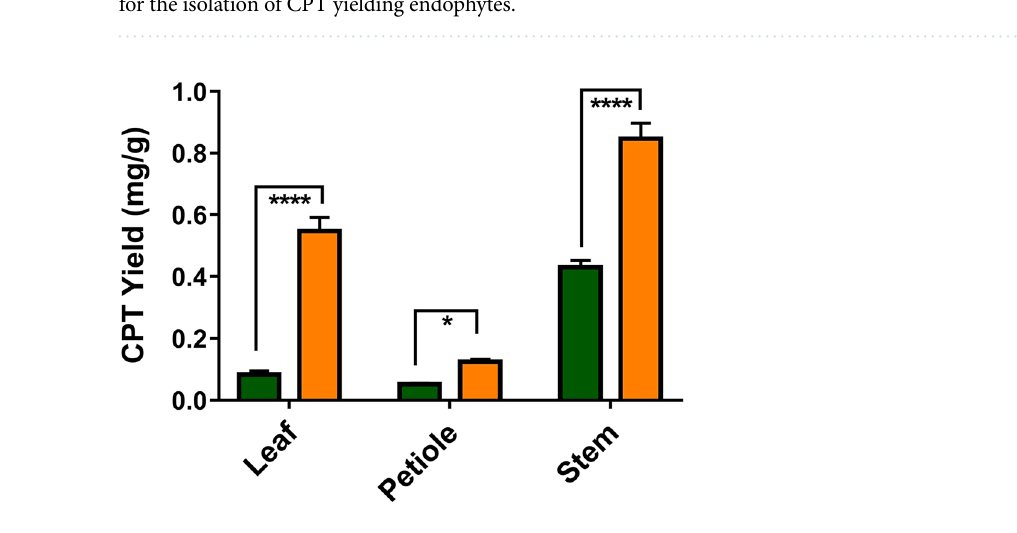
Figure 2. A comparison of CPT yield in different explants (plant parts) obtained from young plantlets and matured plants of N. nimmoniana ( Mature Plant Young